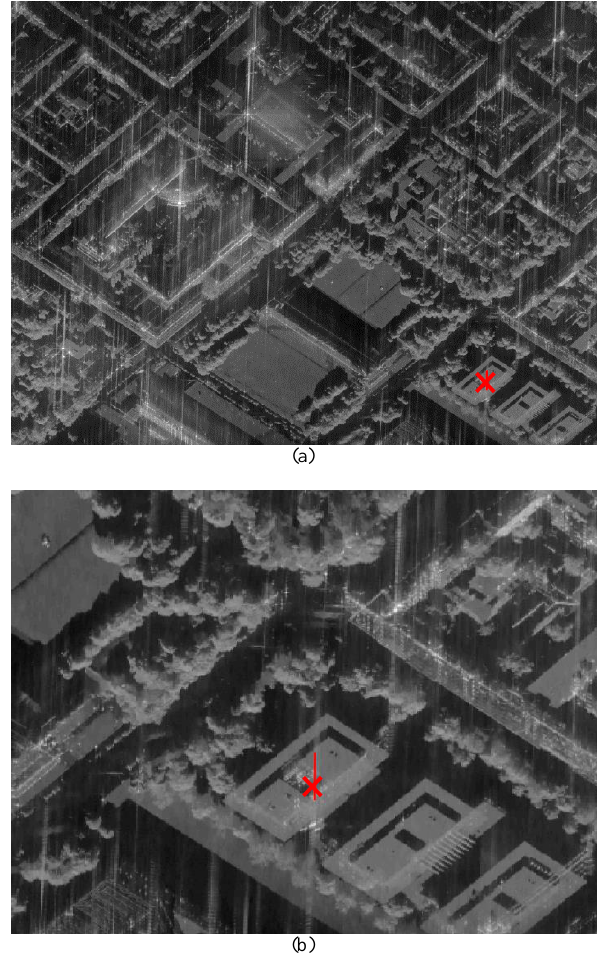
Figure 3. Nonlocally filtered SAR image acquired by the MEMPHIS sensor with a mean pixel spacing of 49cm. (a) Overview. (b) Detail view. Azimuth is from left to right, range from bottom to top. Again the red line indicates the projection history of the PTPs and the red cross shows the finally determined tie point.